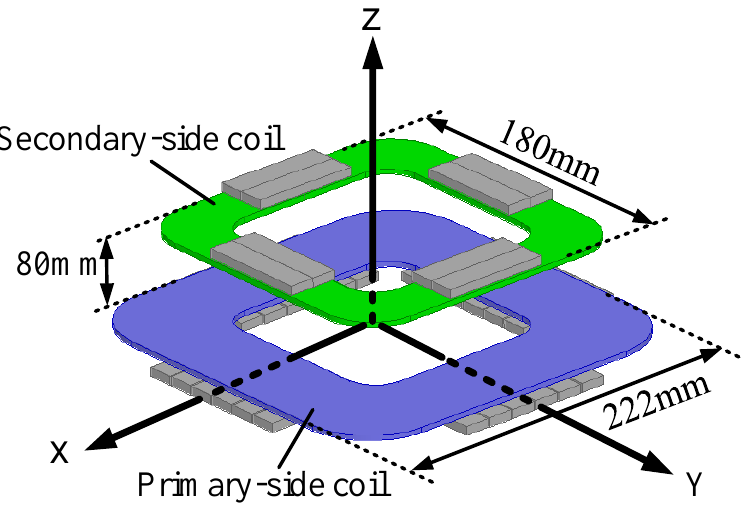
Figure 5. Experimental model of the loosely coupled transformer.